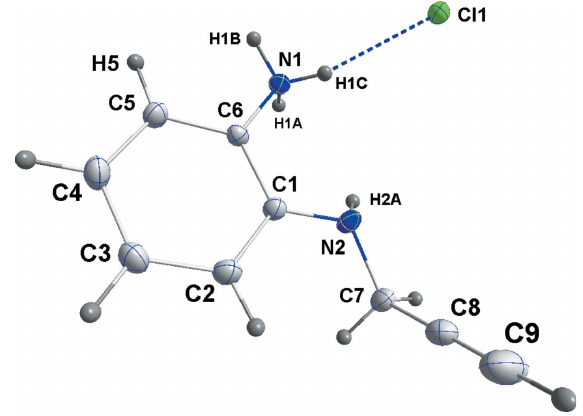
Figure 1 The title molecule with the atom-labelling scheme and 50% probability displacement ellipsoids.